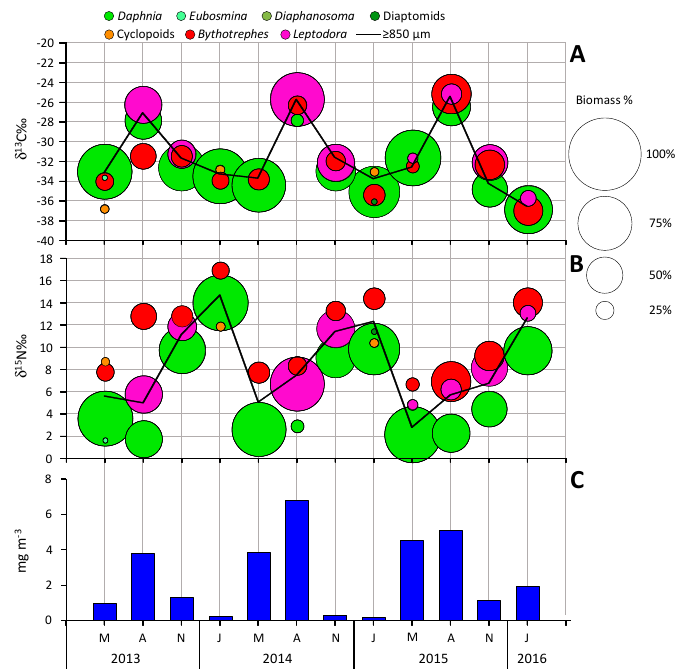
Figure 3. ( A ) Biomass percentage composition of planktonic crustacean taxa (bubbles) of Lake Maggiore and their δ 13 C‰ values (bubble centers) and δ 13 C‰ values of pooled samples (black line); ( B ) biomass percentage composition of planktonic crustacean taxa (bubbles) of Lake Maggiore and their δ 15 N‰ values (bubble centers) and δ 15 N‰ values of pooled samples (black line); ( C ) total biomass of Lake Maggiore planktonic crustacean taxa. All data refer to the fraction ≥ 850 µm.